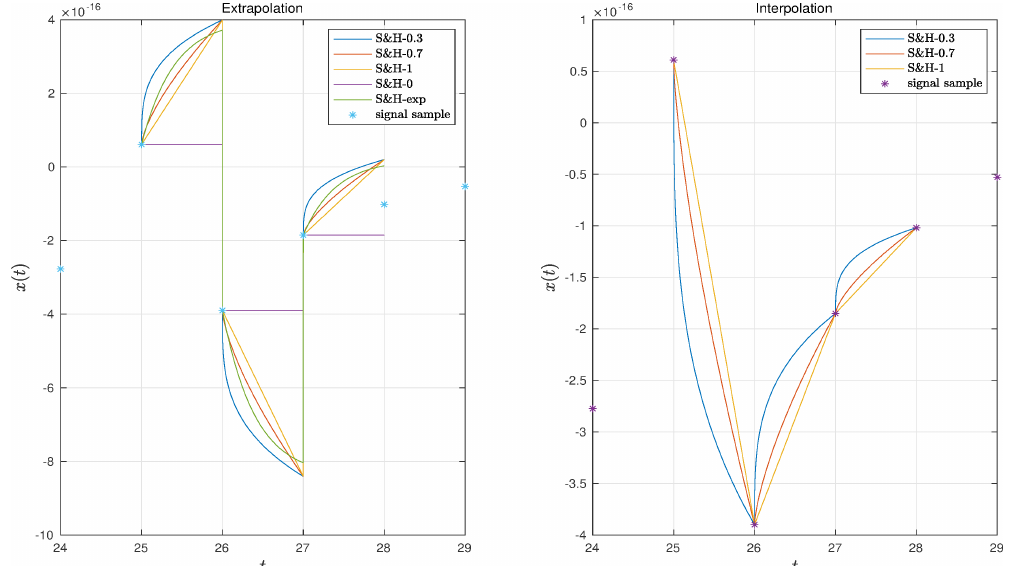
Figure 2. Time response of the extrapolations of the S&H-0 , S&H- α (with α = 0.3 and α = 0.7), S&H-1 and S&H-exp (with τ = 200) and interpolations with S&H- α (with α = 0.3 and α = 0.7) and the